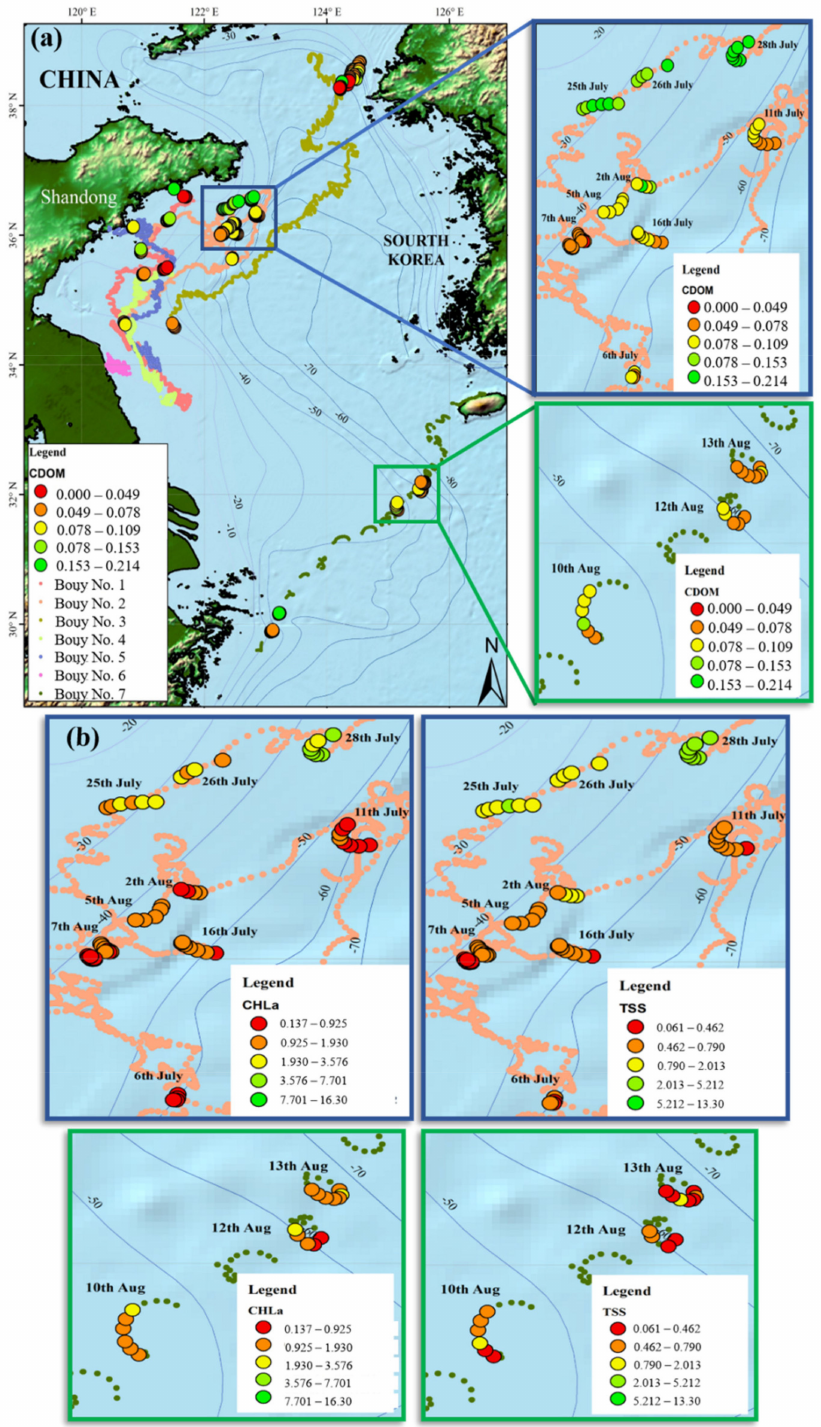
Figure 7. Drifting buoy tracks and ocean color constituent concentrations measured at each site. The upper left image in ( a ) depicts the properties’ values of each matched point on the map, with different range of ag 440 and colors. The remaining panels in ( b ) show enlarged matched areas for Chl a and TSS,